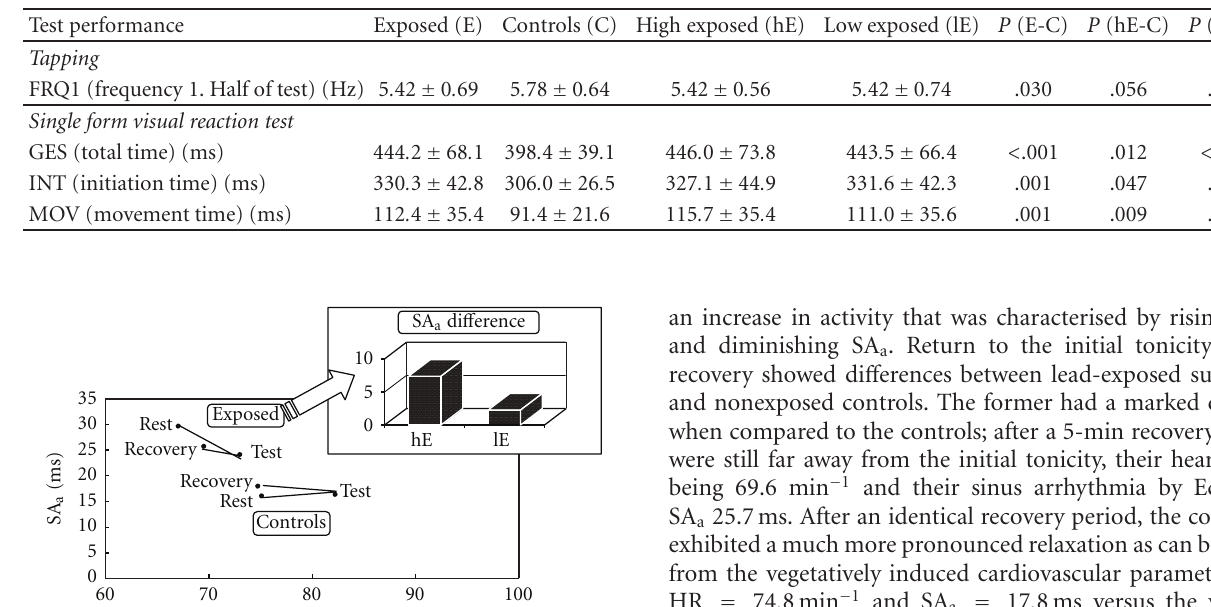
Table 1: Statistically significant performance di ff erence between lead-exposed subjects (E) involving the subgroups of high exposed (hE) and low exposed (lE), and controls (C) in the tapping test and in the single-choice reaction task.